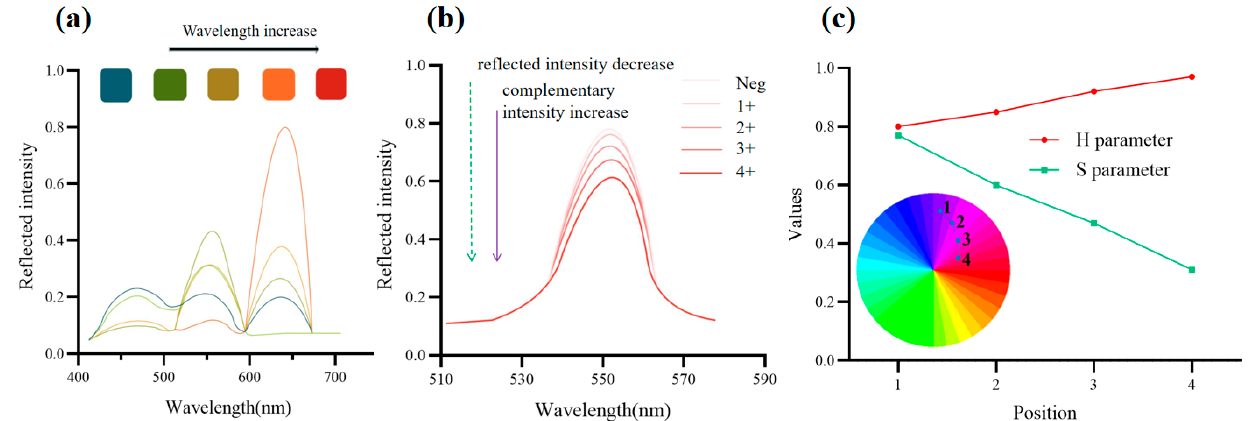
Figure 5. Conversion of color intensity to analytical values. ( a ) The spectra simulated by mixing each RGB spectrum with the same ratios of the displayed colors. ( b ) The displayed spectra simulated to present only at 550 nm with increased glucose concentration. Neg represents a glucose concentration of 0–0.55 mM. The levels “1+, 2+, 3+, 4+”, as positive responses, represent concentrations of 5.6, 14, 28, and 56 mM, respectively. ( c ) Plots for H and S values, along with positions 1 to 4.